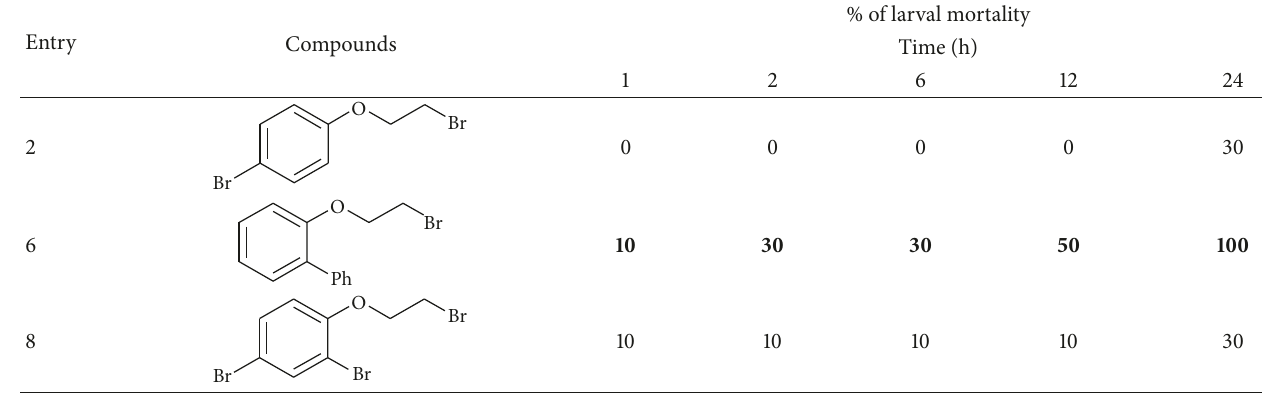
Table 5: Larval mortality of A. aegypti after treatment with 1-bromo-2-aryloxyethane